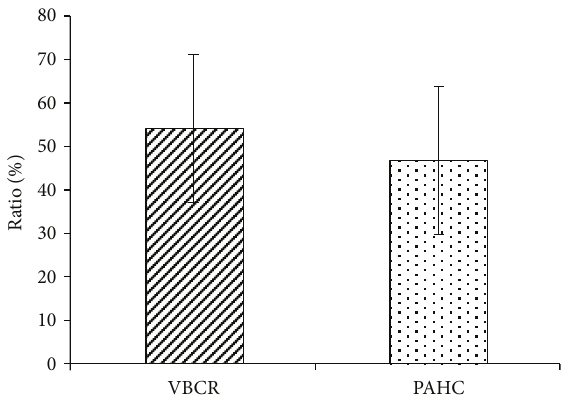
Figure 2: Kyphotic angle measurements.